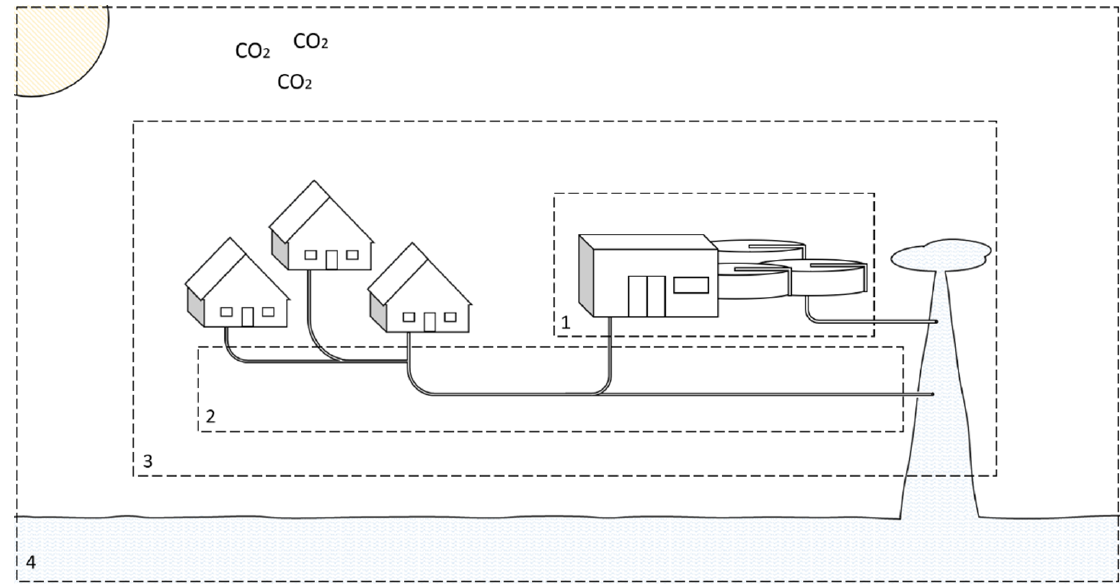
Figure 4. Examples of possible system boundaries (1: WWTP, 2: Piping system, 3: City, 4: Global). Objectives are based on stakeholder values, legal requirements, and other criteria.